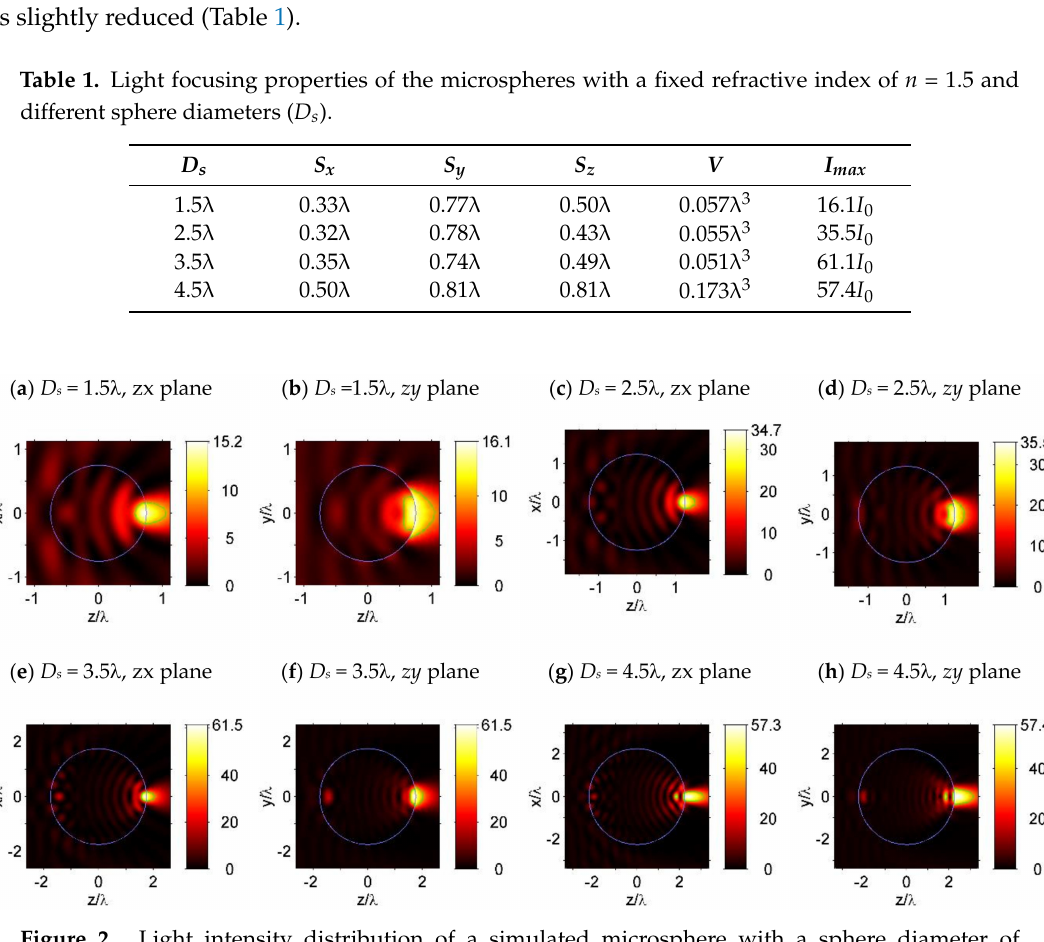
Figure 2. Light intensity distribution of a simulated microsphere with a sphere diameter of ( a , b ) D s = 1.5 λ , ( c , d ) D s = 2.5 λ , ( e , f ) D s = 3.5 λ , and ( g , h ) D s = 4.5 λ . Subfigures ( a , c , e , g ) are plotted in the zx-plane, which is perpendicular to the plane of polarization; subfigures ( b , d , g ), and ( h ) are plotted in the zx-plane, which is the plane of polarization. The Full Width at Half Maximum (FWHM) focal spot of the simulated microspheres are indicated by the contour lines at the value of half maximum light intensity 0.5 I max , which are plotted by the solid green